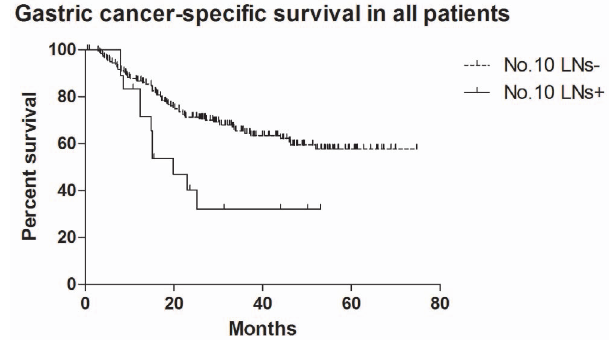
Figure 4. Kaplan-Meier survival analysis of gastric cancer specific group in all patients